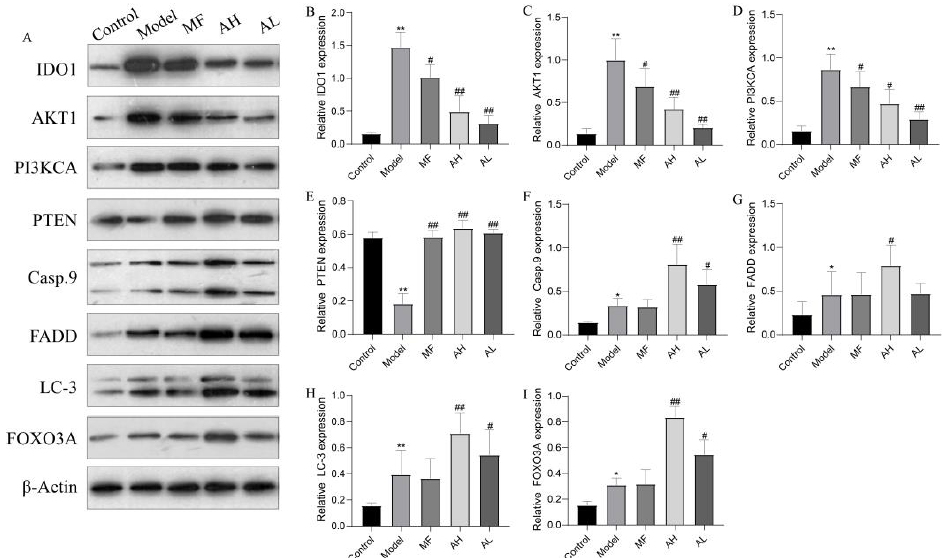
Figure 10. Protein expression of IDO1, PI3KCA, AKT1, PTEN, caspase-9, FADD, LC-3, and FOXO3A in rat uterine tissues by immunohistochemistry (×200). (A) Representative images of immunohisto- chemistry results. (B) Statistical results of IDO1 protein. (C) Statistical results of PI3KCA protein. (D) Statistical results of AKT1 protein. (E) Statistical results of PTEN protein. (F) Statistical results of LC-3 protein. (G) Statistical results of Casp.9 protein. (H) Statistical results of FADD protein. (I) Statistical results of FOXO3A protein. The data are presented as the mean ± SD ( * p < 0.05, ** p < 0.01 compared with the control group; # p < 0.05, ## p < 0.01 compared with the model group).